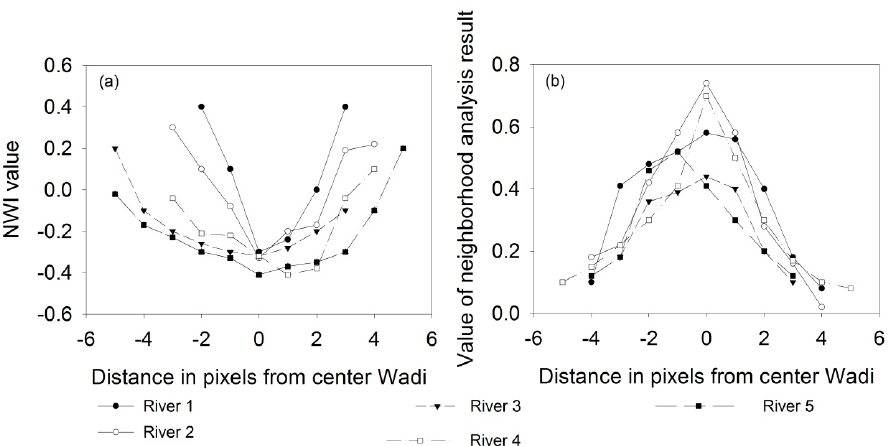
Figure 5. ( a ) WI value profiles of the cross sections of several wadis in a WI image; ( b ) pixel value profiles of the cross-sections of several wadis in neighborhood analysis results.